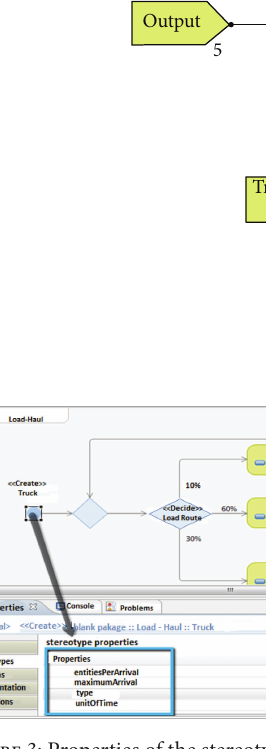
Figure 3: Properties of the stereotype ≪ Create ≫